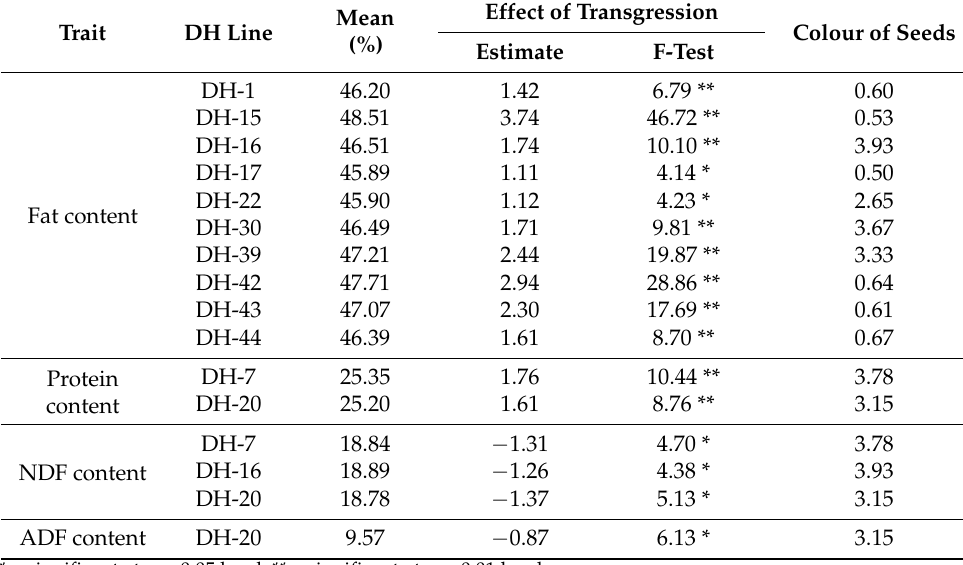
Table 5. DH lines with transgressive